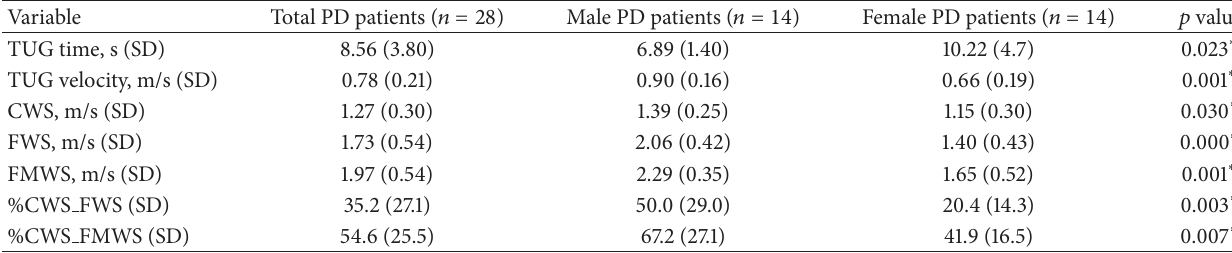
Table 2: Motor performance of PD patients, by